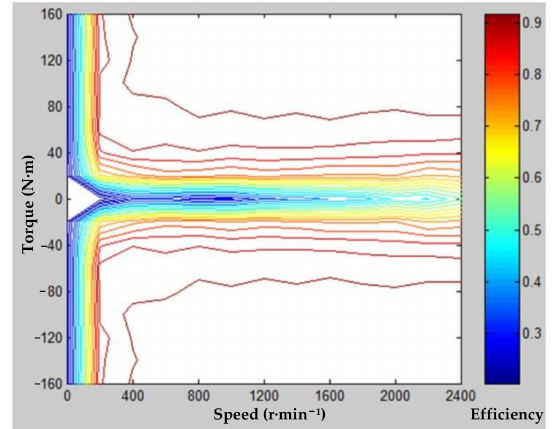
Figure 8. Two dimensional curves of